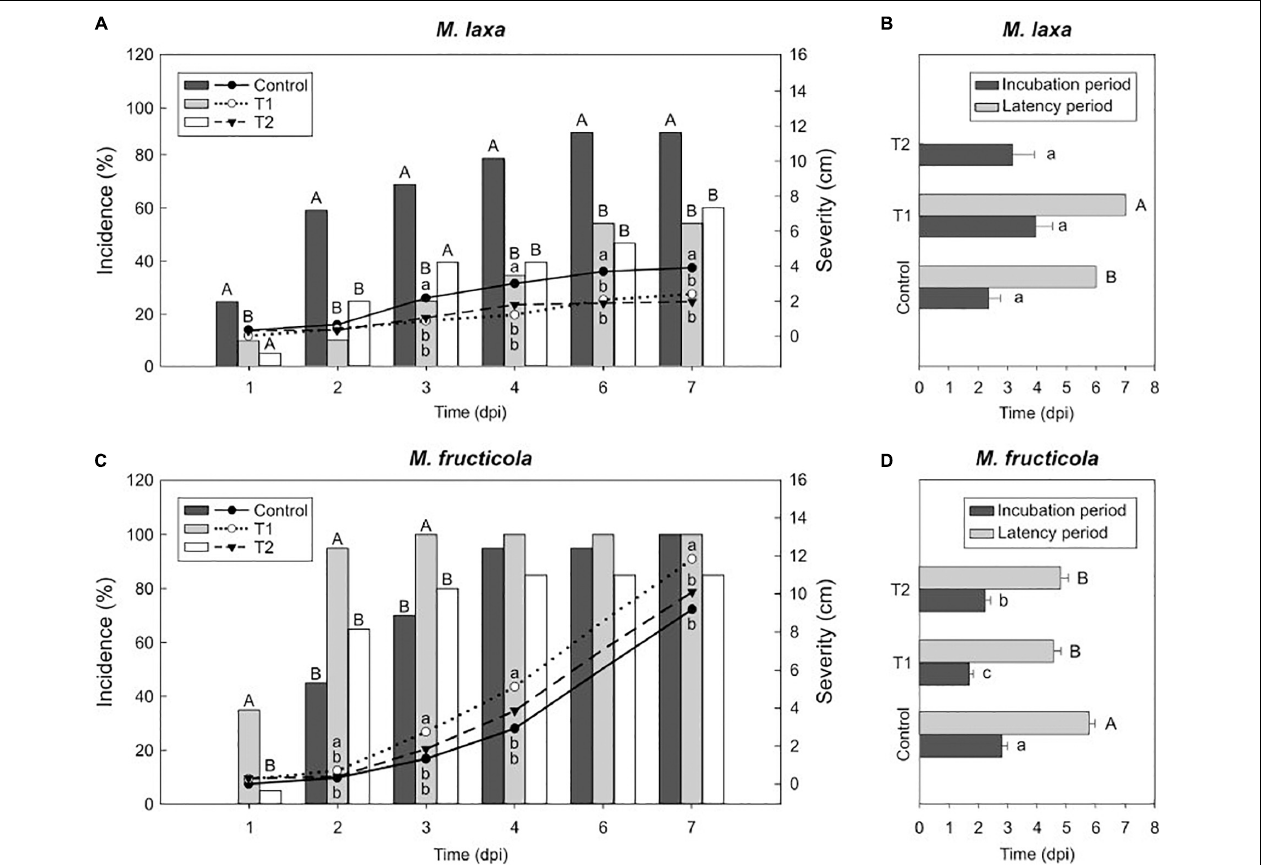
FIGURE 2 | Light effect on the capacity of Monilinia spp. to infect fruit in “Fantasia” cultivar. Incidence (% of brown rot, bars) and severity (lesion diameter length in cm of rotted fruit, lines) of M. laxa (A) and M. fructicola (C) in “Fantasia” nectarines along the infection time course (dpi, days post-inoculation) after growing the fungi for 7 days under treatments 1 and 2 and control condition (constant darkness). Bars represent the mean of incidence on fruit ( n = 20). Lines represent the mean of diameter length of rotted fruit. Different uppercase and lowercase letters indicate significant differences ( P ≤ 0.05) of incidence and severity, respectively, among incubation conditions according to orthogonal contrasts at each time point. No letters indicate no significant differences. Incubation and latency periods (dpi) of M. laxa (B) and M. fructicola (D) in “Fantasia” nectarines after growing the fungi for 7 days under treatments 1 and 2 and control condition. Bars represent the mean of fruits with symptoms ( n = 2 to 20) and error bars represent the standard error of the means. Different lowercase and uppercase letters indicate significant differences ( P ≤ 0.05) of incubation and latency periods, respectively, among incubation conditions according to orthogonal